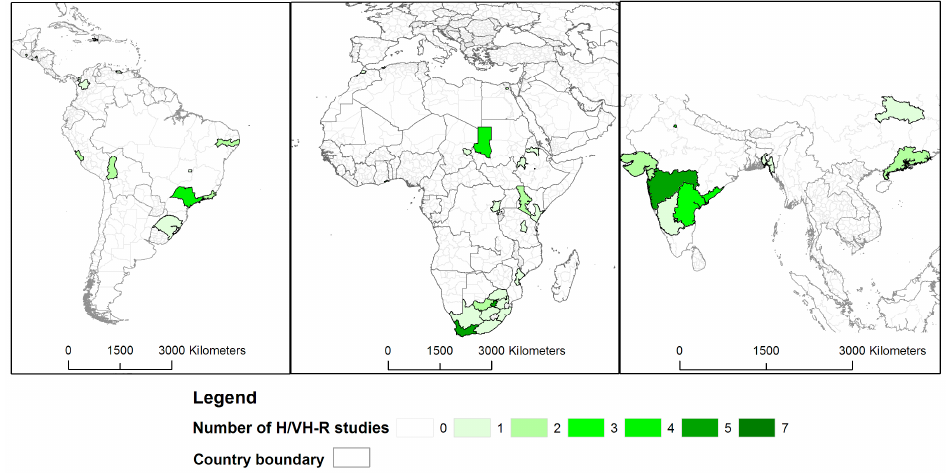
Figure 4. Administrative level distribution of H/VH-R studies.